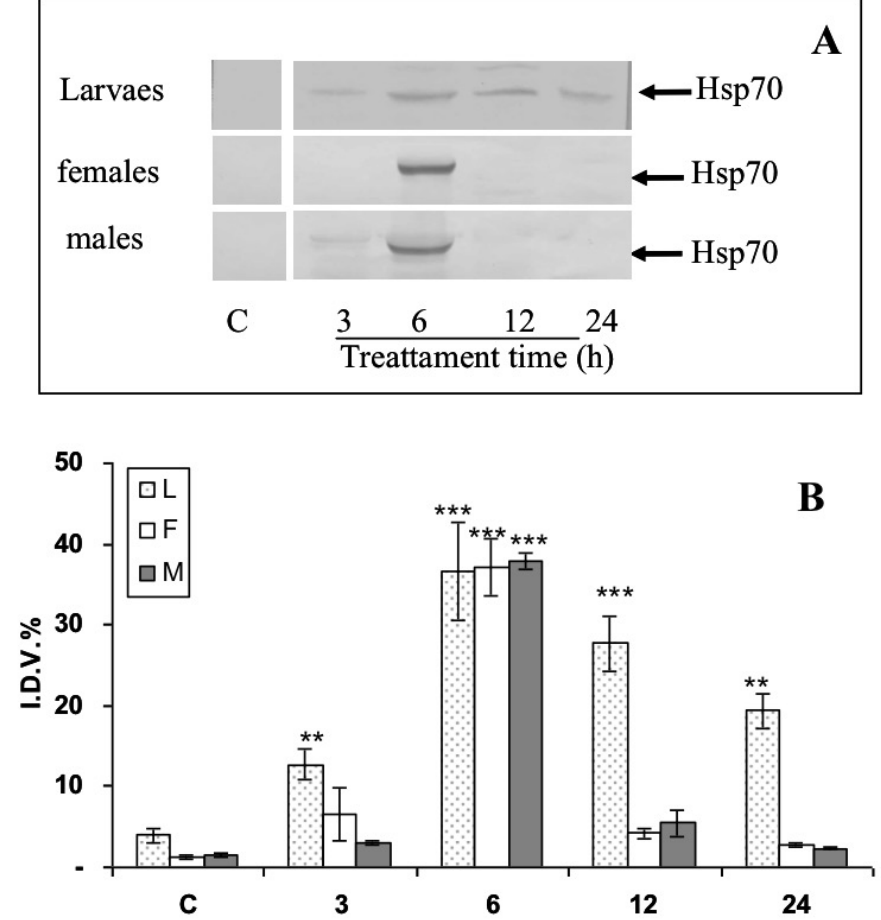
Figure 5. Effects of Bacillus thuringiensis on expression levels of the protein Hsp70 in adults and larvae of brain Rhynchophorus ferrugineus after 3, 6, 12, and 24 h treatment. ( A ) Representative Western blot of Hsp70 levels in three specimens from each group (one for each experimental trial). ( B ) Integrated optical density histogram (IDV) of the Hsp70 protein bands. Data are means ± S.D. (N = 15 control and N = 15 test specimens). Asterisks represent significant differences between control and test groups (** p < 0.01; *** p < 0.001).